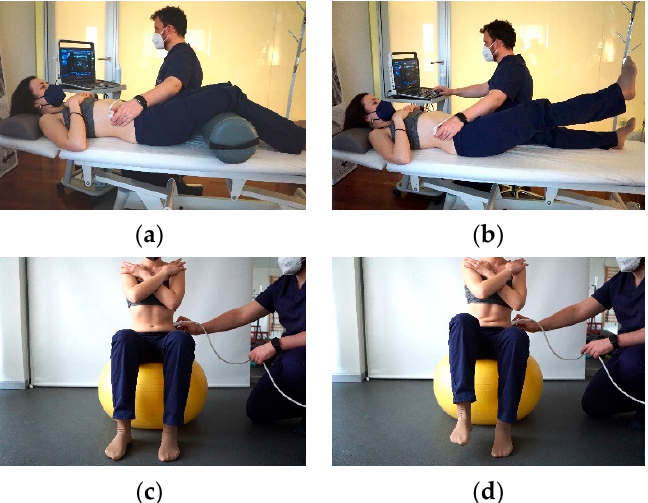
Figure 1. Images representing the positions used to measure TA muscle thickness at rest and contrac- tion in different positions to obtain the CR ( a ) Transversus abdominis (TA) thickness measurement in supine lying (static at rest) with 60-degree hip flexion, ( b ) TA thickness measurement in supine lying during holding the lower extremity in the raised position, ( c ) TA thickness measurement in at rest on Fitball, ( d ) TA thickness measurement in contraction on Fitball with contralateral foot